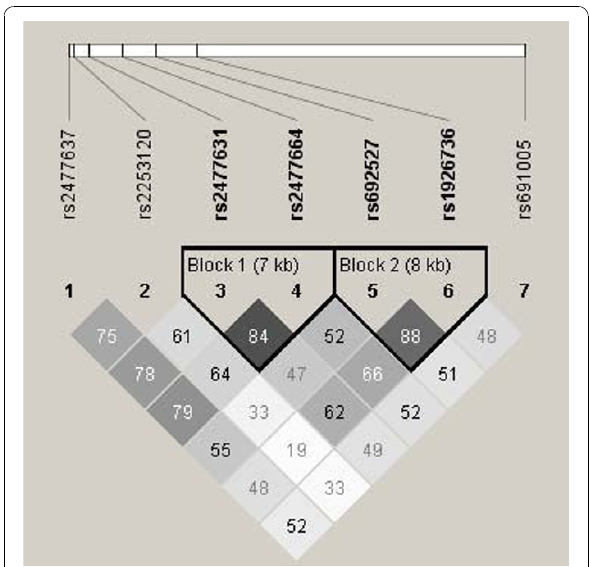
Figure 1 Linkage disequilibrium structure (LD) of MRC1 gene across the 98.8 kb in Japanese (n = 605). Black squares represent high pairwise linkage disequilibrium, coloring down to white squares of low pairwise linkage disequilibrium. The numbers in the individual squares are D ’ multiplied by